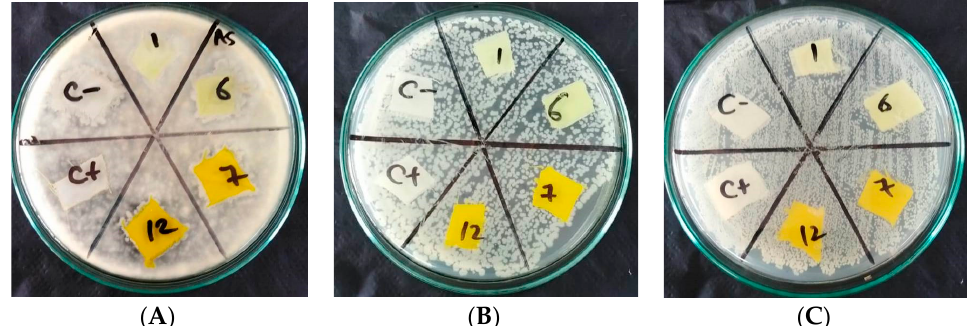
Figure 11. Aspergillus flavus ( A ), Bacilluscereus ( B ), and Staphylococcussciuri ( C ) treated with dyes 18h and 18i.